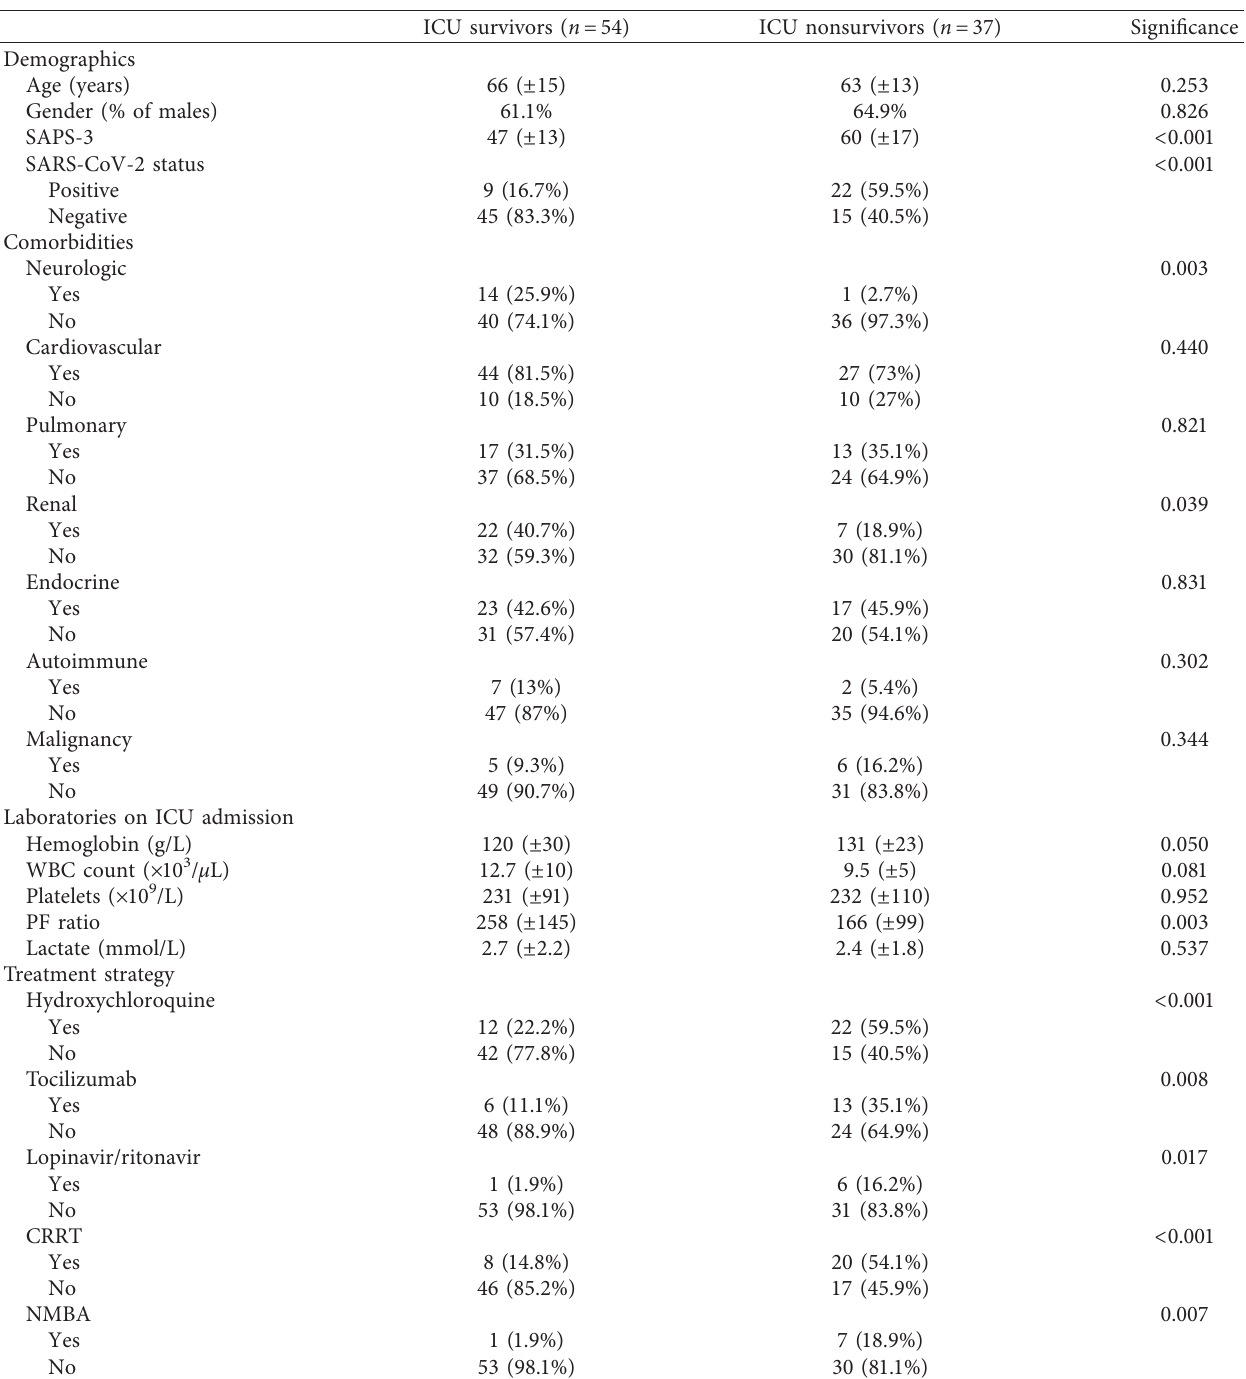
Table 3: Variables and